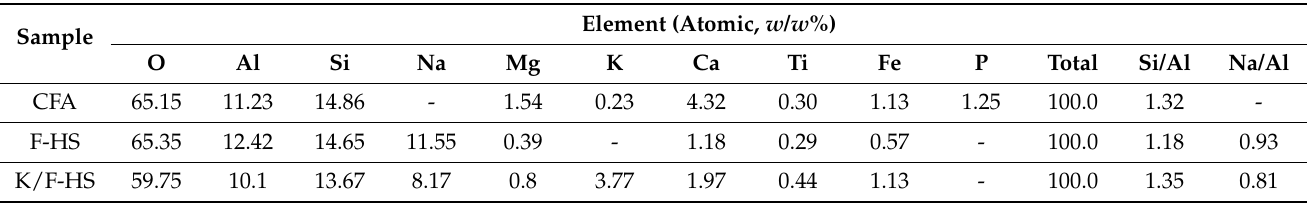
Figure 2. SEM image of ( a ) Fusion-assisted HS zeolite (F-HS), ( b ) Ion exchange-modified zeolite (K/F-HS). (K/F-HS). Table 1. Elemental composition showing the effect of ion exchange-modification on produced fusion-assisted hydrothermal HS